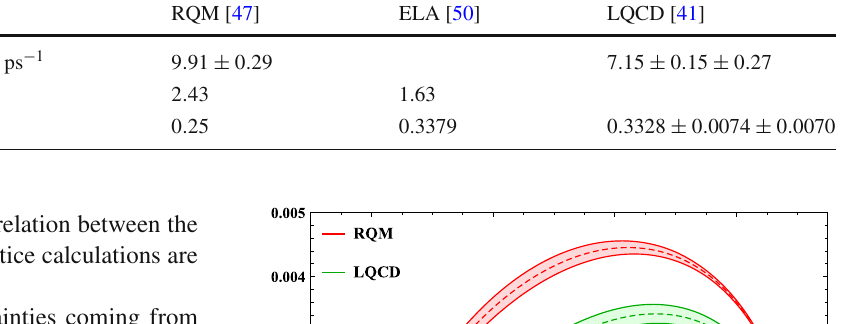
Table 2 Theoretical predictions